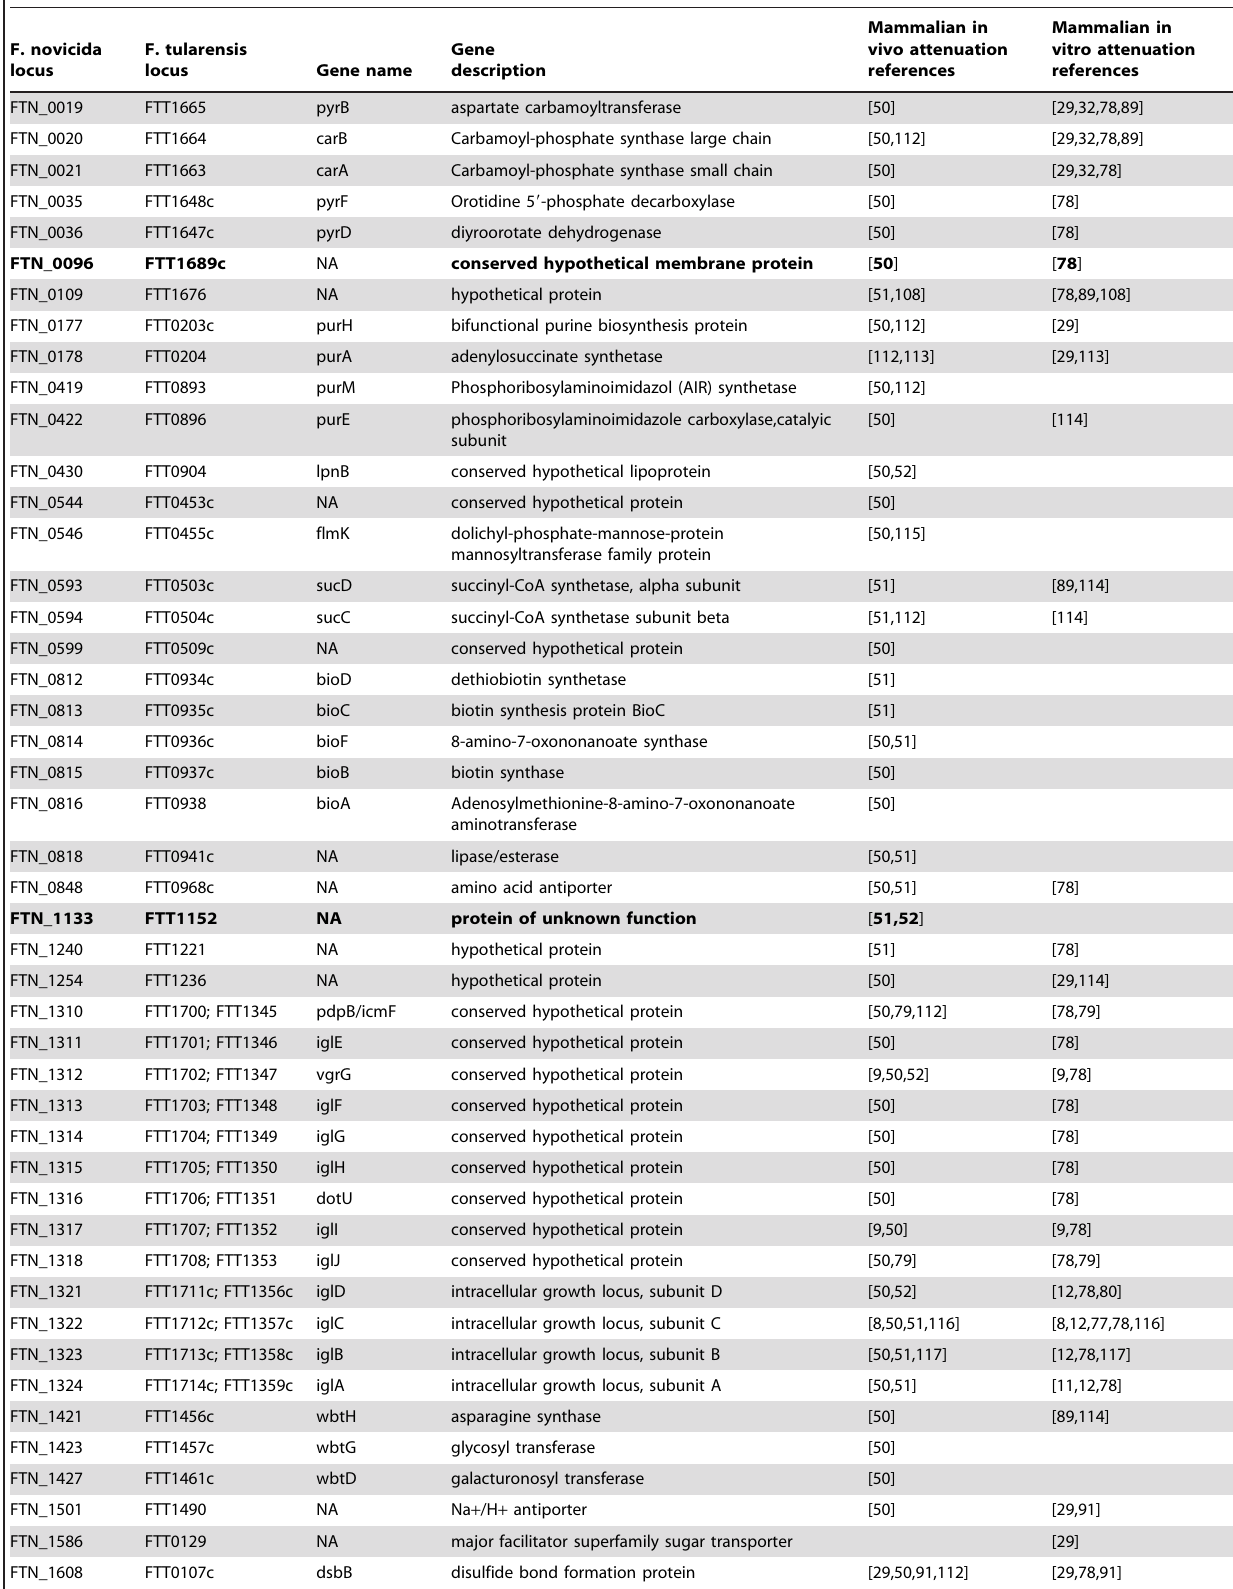
Table 1. List of genes required for replication in RAW264.7